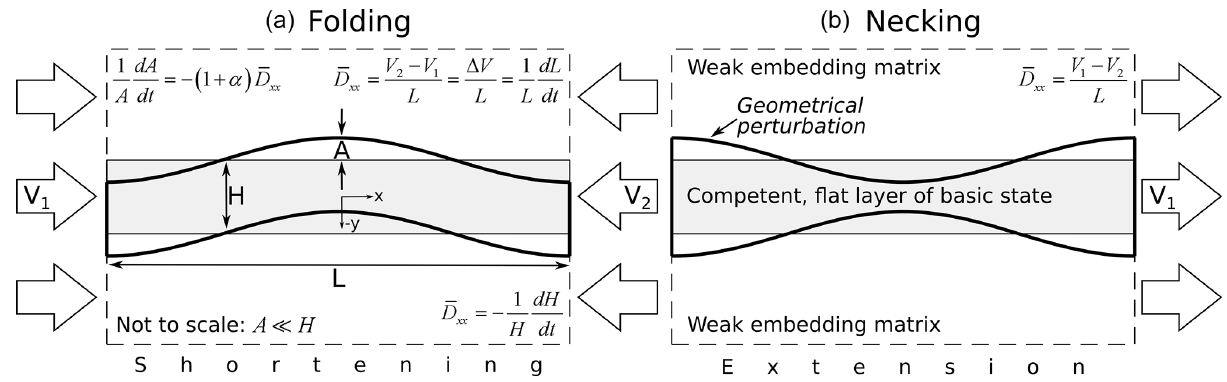
Figure 11. Configuration for analytical folding (a) and necking (b) models with some basic equations. A is amplitude, H is layer thickness, L is wavelength, V 1 , 2 are horizontal boundary velocities, t is time, α is amplification rate and ¯ D xx is the applied bulk rate of